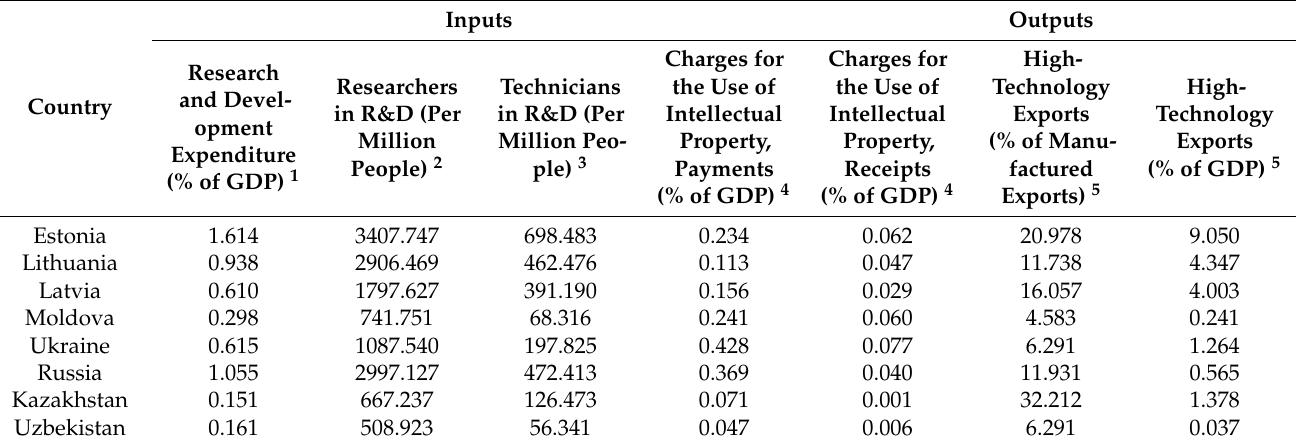
Table 1. Inputs and outputs of the DEA model for NIS in post-Soviet countries (mean for 2011–2018). Inputs